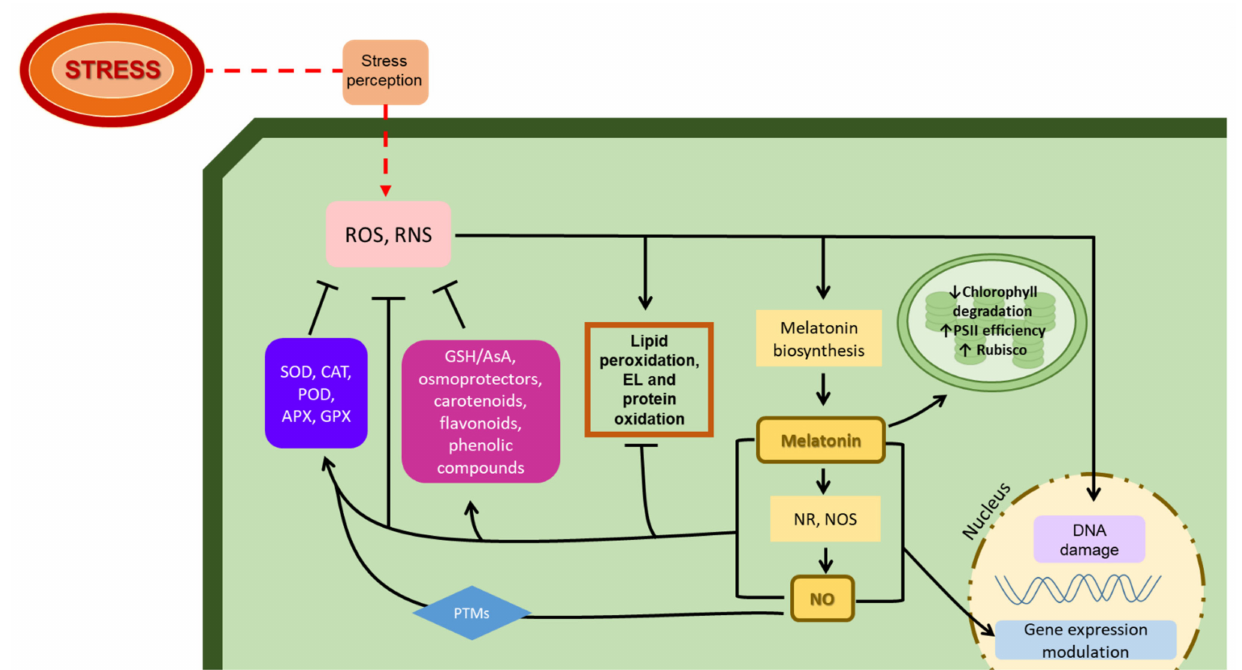
Figure 2. General mechanisms for MEL- and NO-mediated stress response. Stress causes an increase in ROS and RNS levels, which damage plant cells. Increased ROS levels trigger MEL production, which can also promote NO synthesis. Both MEL and NO directly scavenge ROS and RNS and promote the activity of antioxidant enzymes, the accumulation of antioxidant molecules, and osmo- protectants, and influence gene expression, thus alleviating the effects of stress on